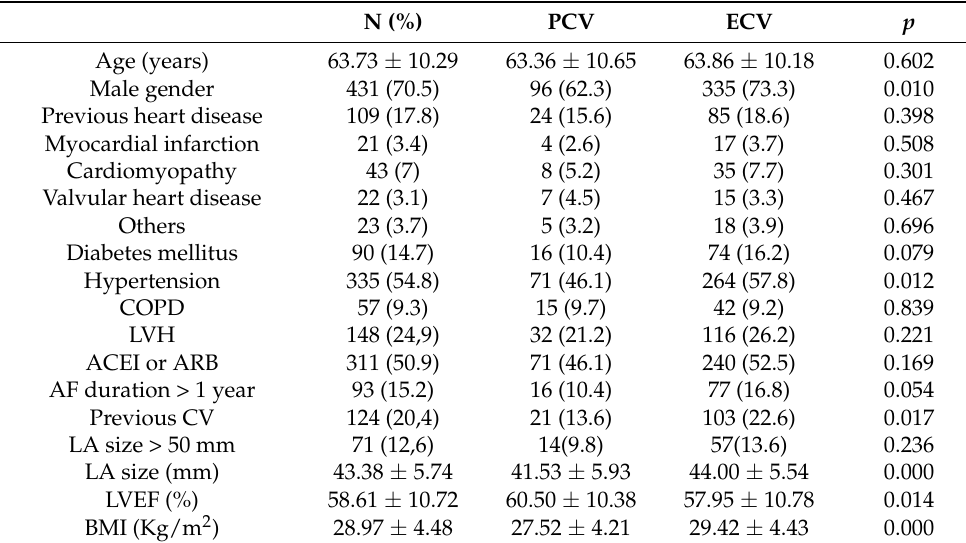
Table 1. Baseline characteristics of the 611 patients included.